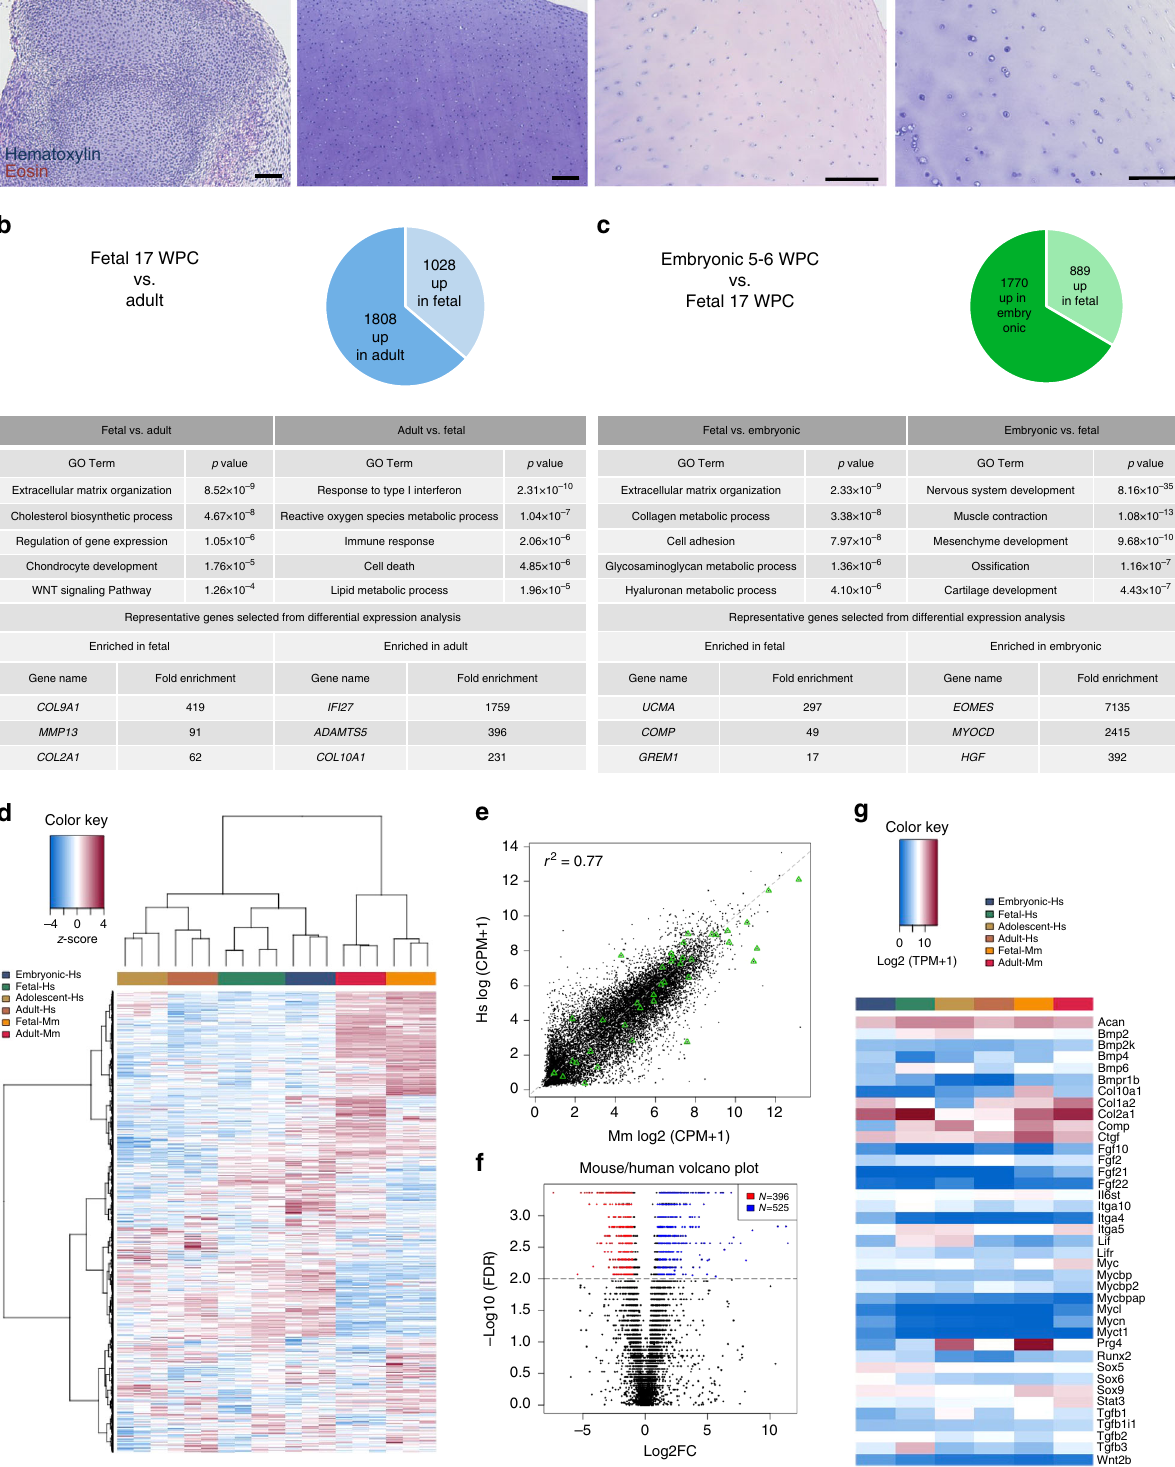
Fig. 3 Transcriptional differences across human and mouse cartilage development. a Hematoxylin and Eosin (H&E) staining showing tissue architecture of chondrocytes at each stage pro fi led. b Selected Gene Ontology (GO) terms and genes enriched between fetal 17 WPC (weeks post conception; left) or adult (right) chondrocytes. c Selected GO terms and genes enriched between fetal 17 WPC (left) or embryonic 5 – 6 WPC (right) chondrocytes. d Hierarchical clustering of 15,000 genes expressed across 4 stages of human ontogeny and 2 stages of mouse development. e Mean enrichment plot between mouse and human samples. Green triangles represent selected chondrogenic genes. f Volcano plot showing differentially expressed genes between mouse and human. g Heat map (logarithmic expression) of chondrogenic genes shown in mean enrichment plot across all human and mouse samples. Hs: human, Mm: mouse, FC: fold change. N = 3 – 4; scale bars = 50 μ